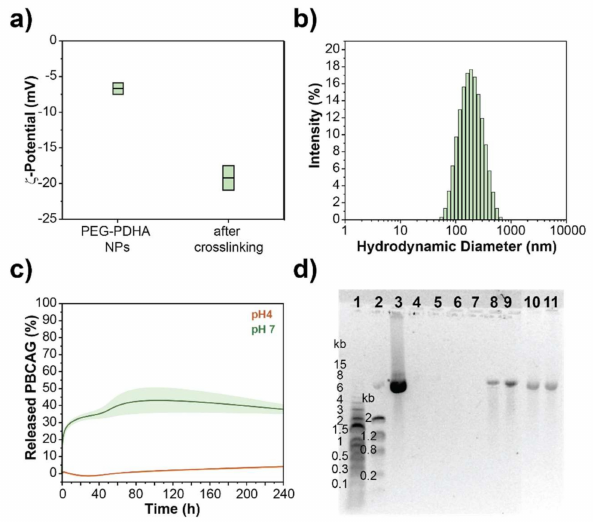
Figure 5. PEG-PDHA crosslinked nanoformulation. ( a ) The ζ -potential of PEG-PDHA NPs before and after crosslinking. ( b ) Hydrodynamic size distribution of PEG-PDHA crosslinked nanoformulation. ( c ) Release kinetics of PBCAG from crosslinked PEG-PDHA nanoformulation. ( d ) Representative gel electrophoresis of PBCAG release from PEG-PDHA crosslinked nanoformulation. Well 1: 1 kb DNA ladder, Well 2: low DNA mass ladder, Well 3: PBCAG, Well 4–11: PEG-PDHA NPs encapsulating PBCAG after 0, 0.5, 1, 3, 24, 48, 72 and 240 h incubation at 37 ◦ C,